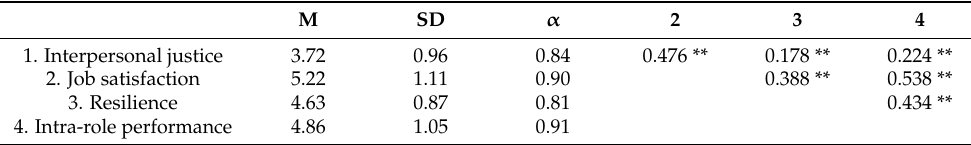
Table 1. Descriptive data, internal consistencies, and correlations.